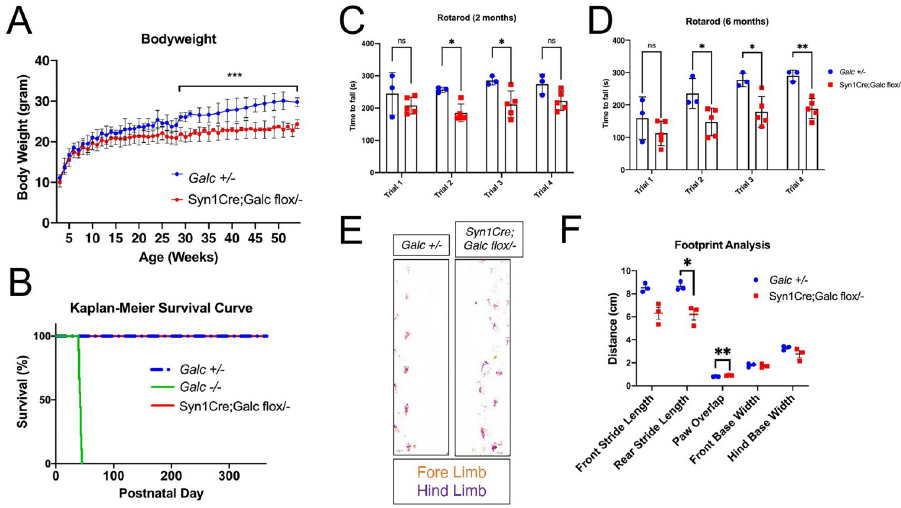
Fig 3. Syn1Cre; Galc flox/− mice have motor coordination defects with muscular wasting. ( A ) Body weight of Syn1Cre; Galc flox/− mice were dramatically reduced compared to control ( Galc +/− ). Female animals only were tested. N = 10 per genotype. ( B ) Syn1Cre; Galc flox/− mice survives more than 1 year, like control ( Galc +/− ). N = 15 each genotype. ( C, D ) Rotarod analysis of 2-month-old ( C ) and 6-month-old ( D ) animals shows that Syn1Cre; Galc flox/− mice had a poor performance, which was initially apparent at 2 months and became more pronounced at 6 months of age. Rotarod was performed with acceleration from 4 rpm to 40 rpm, for 300 seconds or to failure. N = 4 for Syn1; Galc flox/− and N = 5 for Galc +/− . Female animals only were tested. ( E ) Representative images of the footprint analysis of the 1.5-year-old Syn1; Galc flox/− and control ( Galc +/− ). Purple food-safe dye was used for the hind limbs, and orange food-safe dye was used for the forelimbs. Each mouse was given 3 trials of the test and the results from test 2 and 3 were pooled. N = 3. ( F ) Quantification of the footprint analysis shows impaired coordination in both paw placements, as measured in overlap, and a shorten rear limb stride length. Data are presented as mean values ± SEM; � P < 0.05, �� P < 0.01. The underlying data for A – D and F can be found in S1 Data. GALC,